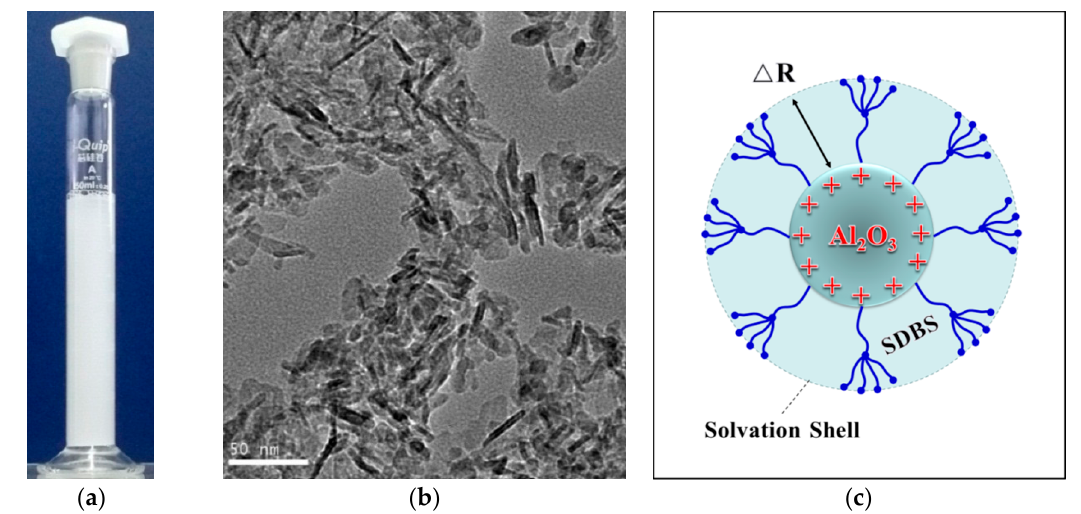
Figure 1. Dispersion stability of Al 2 O 3 -H 2 O nanofluids and its microcosmic mechanism: ( a ) Nanofluids standing for 4 h; ( b ) Scanning electron microscopy images of γ -Al 2 O 3 nanoparticles; ( c ) Stable structure of the electron double layer.